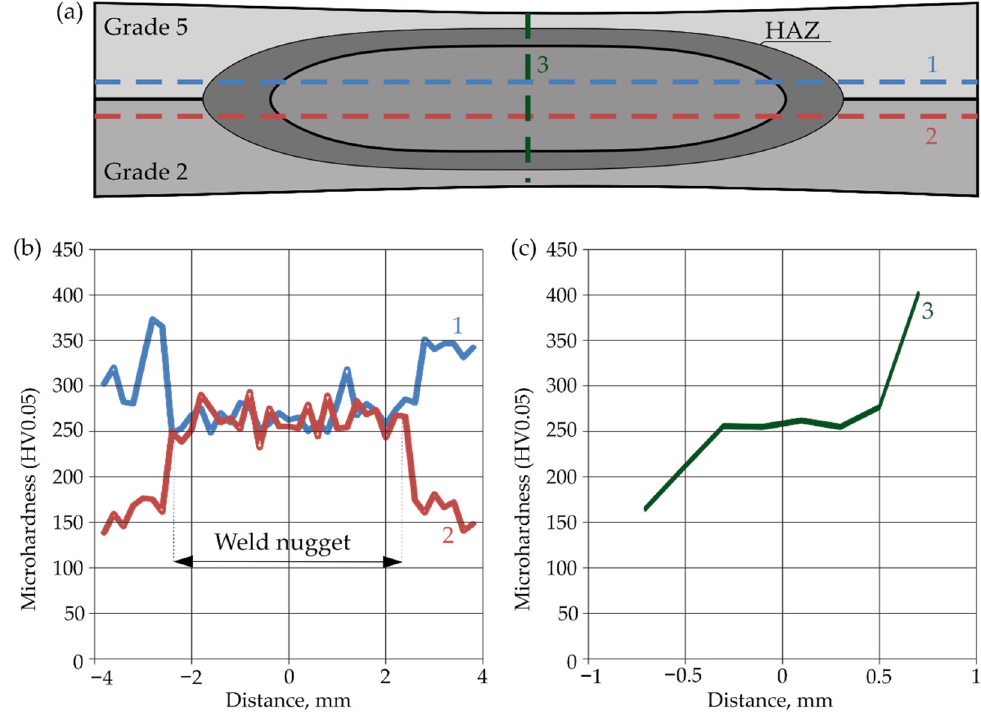
Figure 12. Microhardness of Gr2–Gr5 joints: ( a ) horizontal and vertical measurement lines; ( b ) hor- izontal hardness distributions and ( c ) vertical hardness distribution.